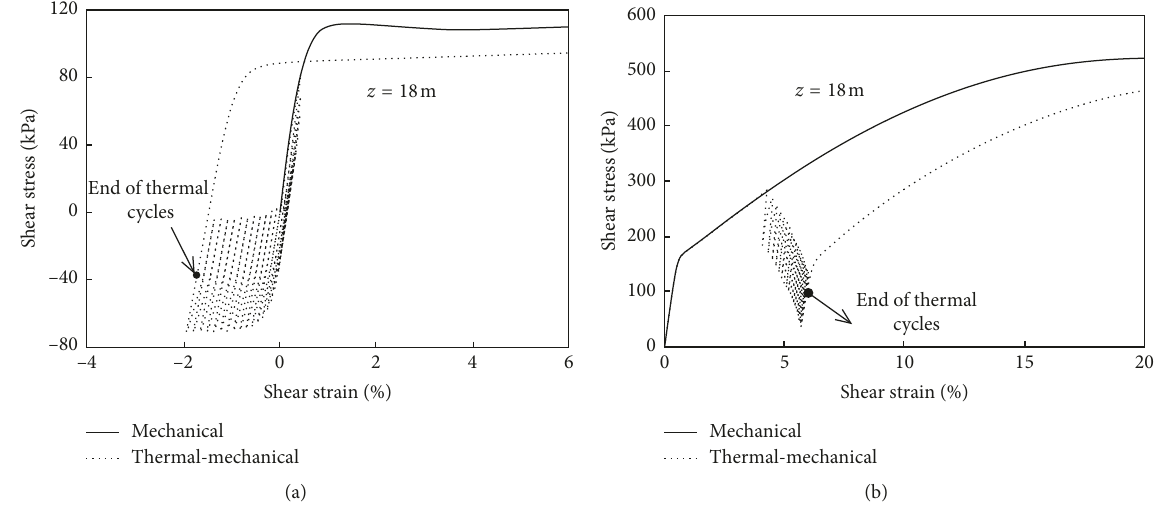
Figure 17: Development of shear stress at pile-soil interface for the restrained head pile. (a) Pile in loose sand. (b) Pile in dense